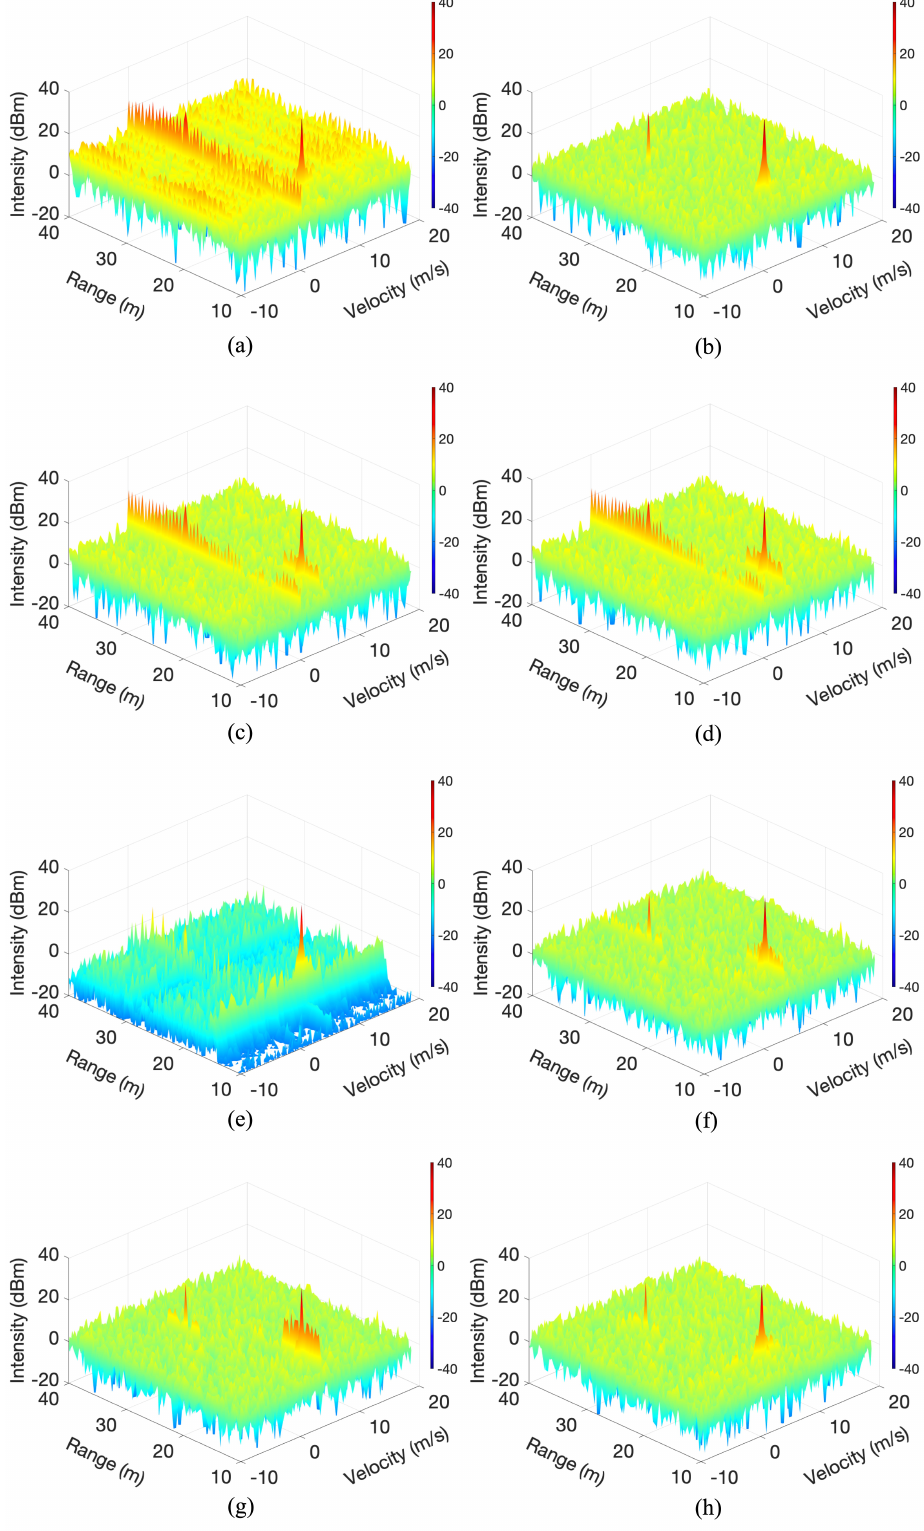
Figure 8. Comparisons on dynamic interference simulations. ( a ) Original image; ( b ) Interference- free image; ( c ) Lee et al. [19]; ( d ) Lee et al. [19] + Proposed interference detection; ( e ) Uysal [23]; ( f ) Uysal [23] + Proposed interference detection; ( g ) Brooker [15]; and ( h ) The proposed